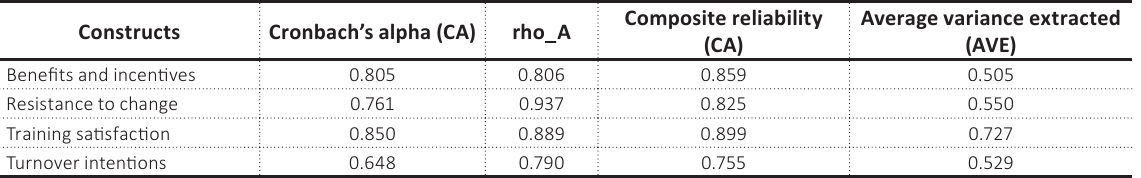
Table 3. Construct reliability and